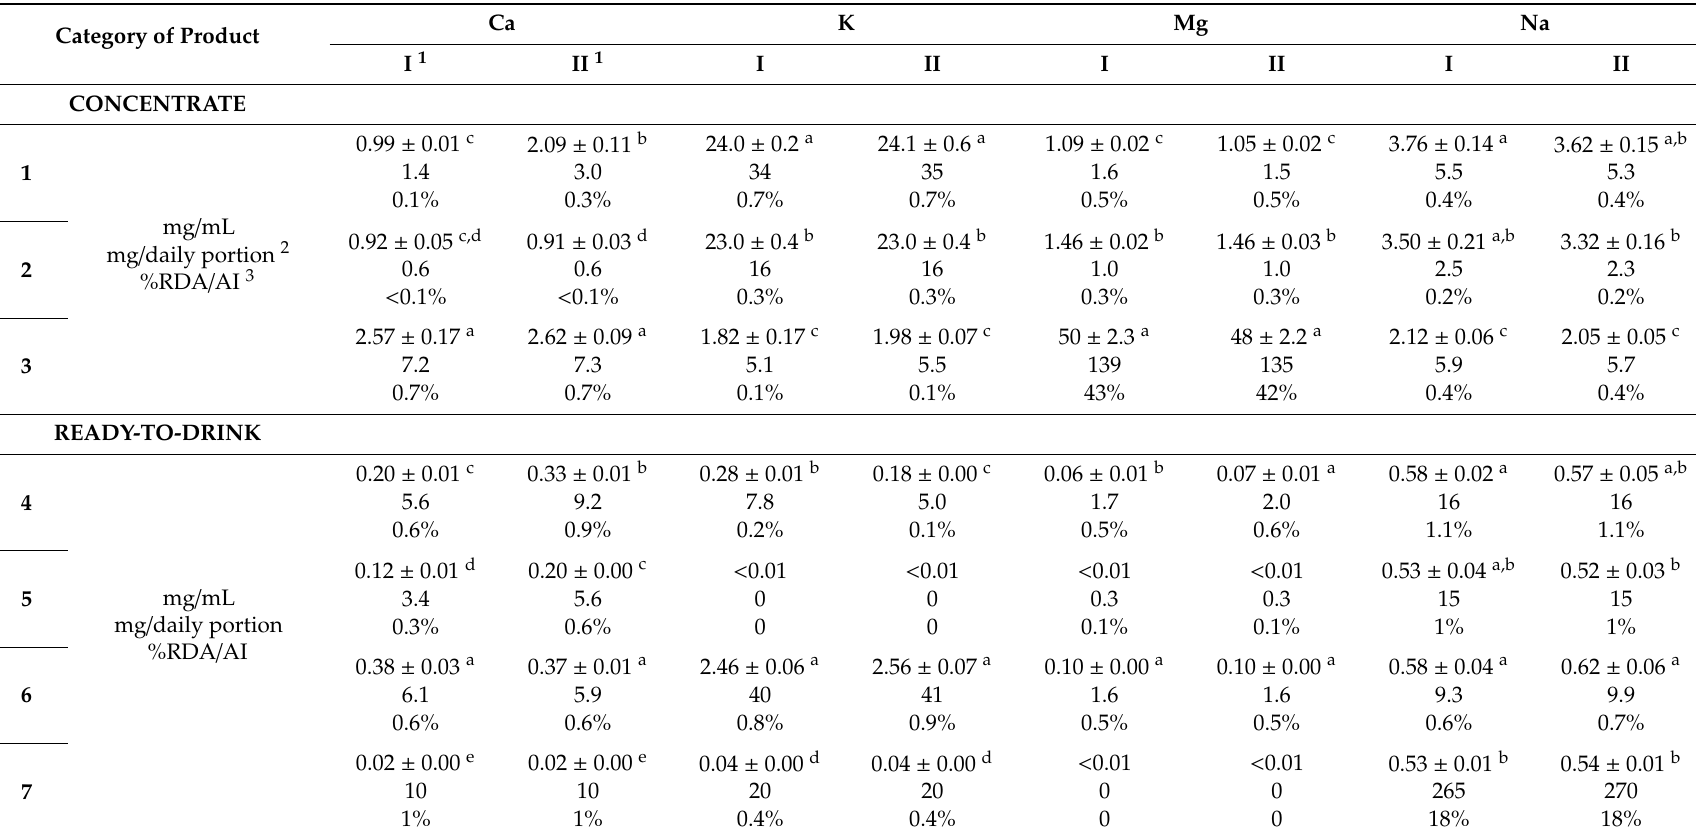
Table 1. The content of macroelements in fulvic acid